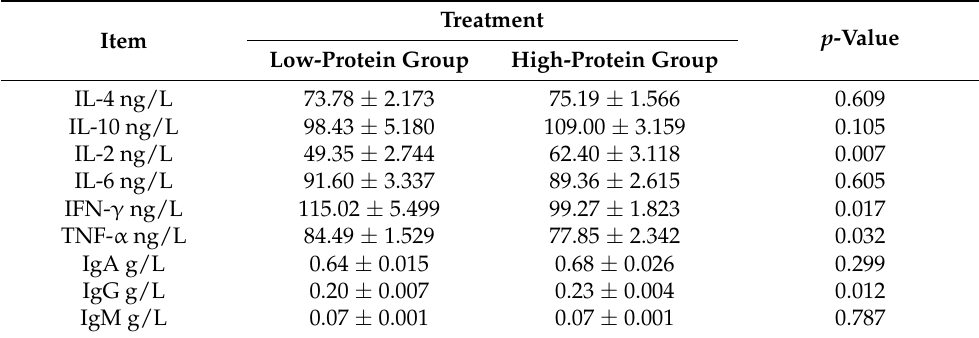
Table 6. Effects of the dietary protein level on the plasma cytokine and immunoglobulin content of growing